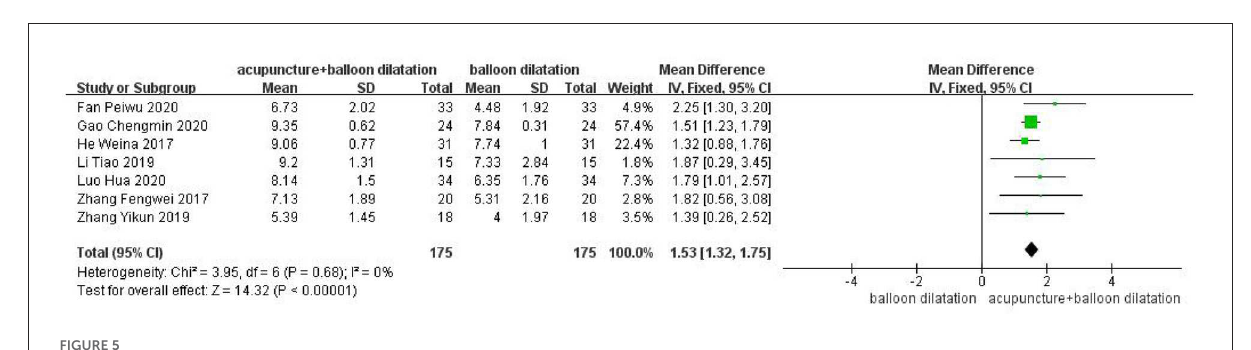
FIGURE5 Forest plot for the VFSS